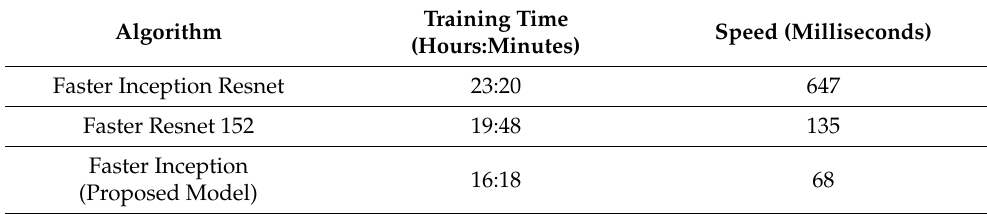
Table 9. Computational cost